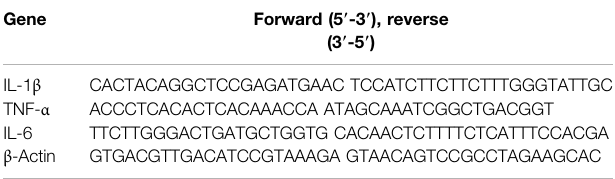
TABLE 1 | Real-time PCR primer